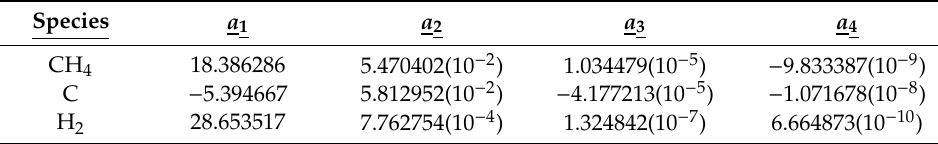
Table A1. Coe ffi cients for use in Equation